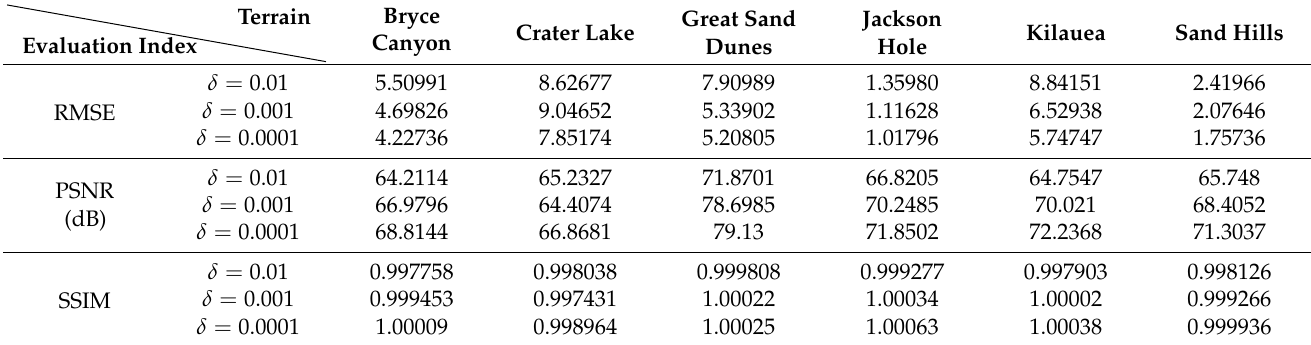
Table 2. Evaluation index of SR-DEM with different δ using No. 1 training datasets ( m = 100 ) .